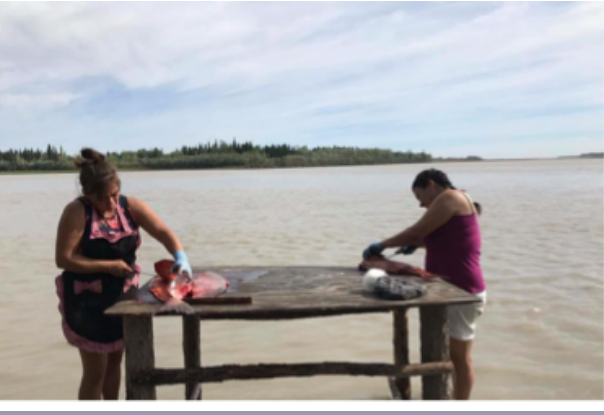
Fig. 2. Shannon Hardy and Jessica Black cutting Łuk Choo on the Yukon River, 2017. Photo credit: Michael